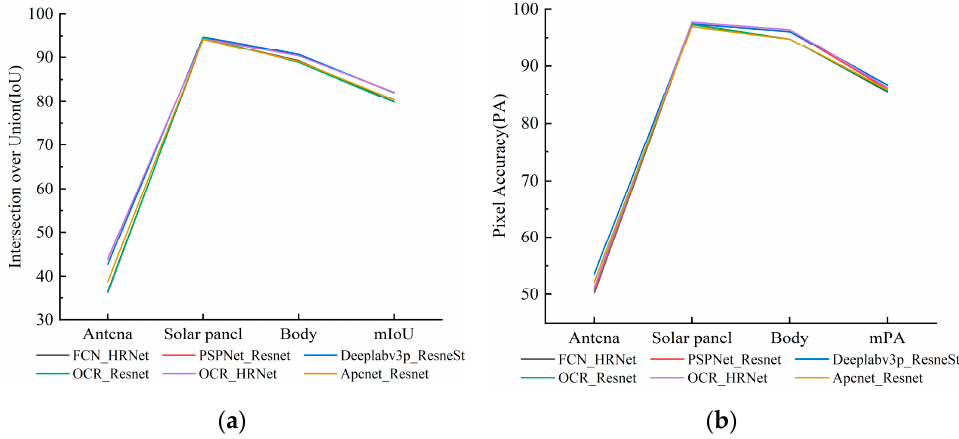
Figure 15. Various types of accuracy and overall accuracy obtained by training of the mixed dataset and validation of the real-shot validation dataset: ( a ) intersection over union; ( b ) pixel accuracy. The training results of spacecraft dataset and mixed dataset were validated on the real-shot validation dataset. The two kinds of validation accuracy were compared, as shown in Figure 16.